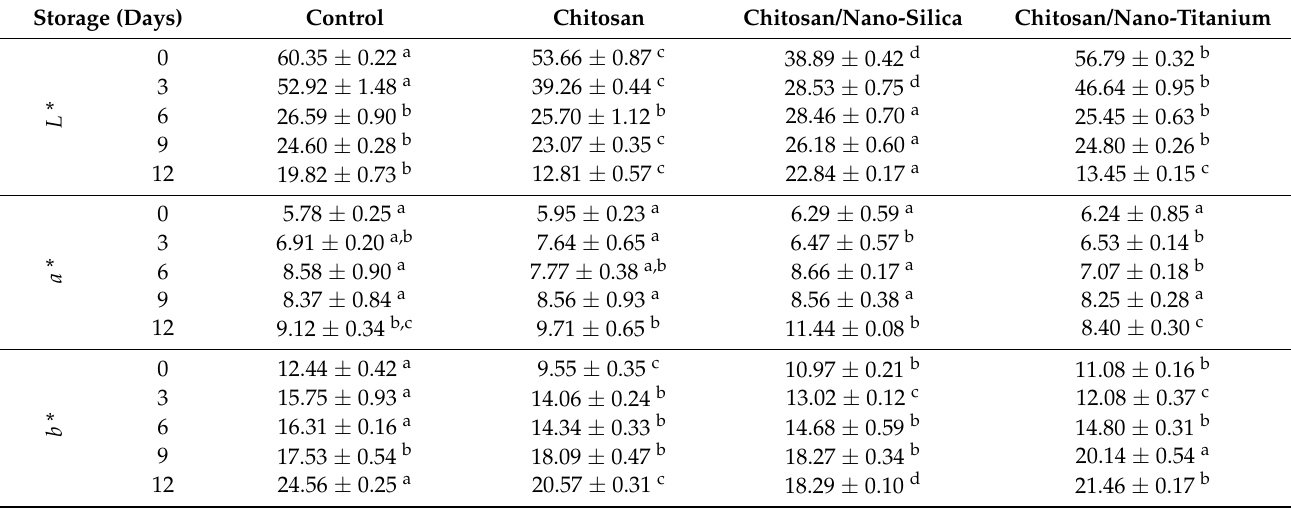
Table 1. The values L *, a *, and b * from white button mushrooms treated with the control, Chitosan, Chitosan/nano-silica, and Chitosan/nano-titanium stored at 4 ◦ C for 12 days.